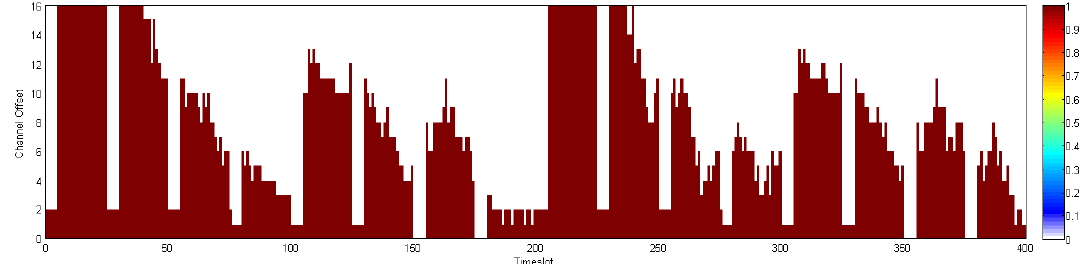
Figure A6. Communication schedule of WirelessHART network with seven nodes per one-hop neighborhood.